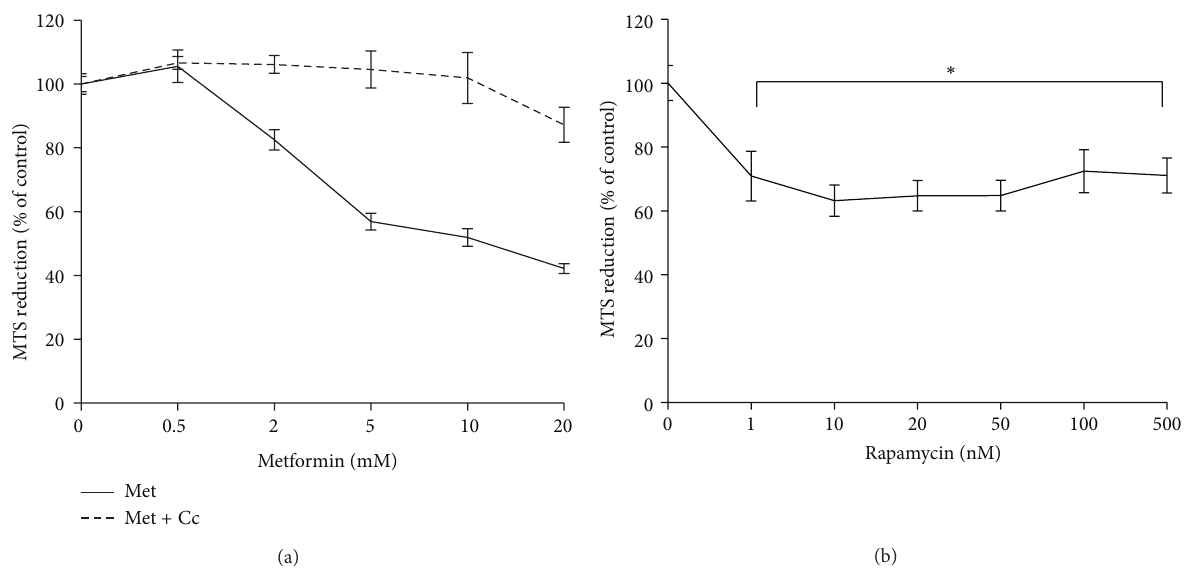
Figure 1: Inhibition of HEK293 cell proliferation by metformin (a) and rapamycin (b). 5000 cells per well were seeded in 96-well plates in MEM, cultured overnight and then exposed to increasing concentrations of metformin (Met) and rapamycin for 24 h. In combination with metformin treatments, 20 𝜇 M of compound C (Cc) was used. Cell proliferation was measured by the MTS cell proliferation assay. Composite results expressed as mean ± SEM of three independent experiments. (a) Mixed ANOVA: within subject effects of metformin concentration ( 𝐹(5,85) = 52.48 𝑃 < 0.001 ), between subject effects of combination treatments with compound C 𝐹(1, 17) = 52.15 𝑃 < 0.001 . (b) ∗ 𝑃 < 0.05 , compared with